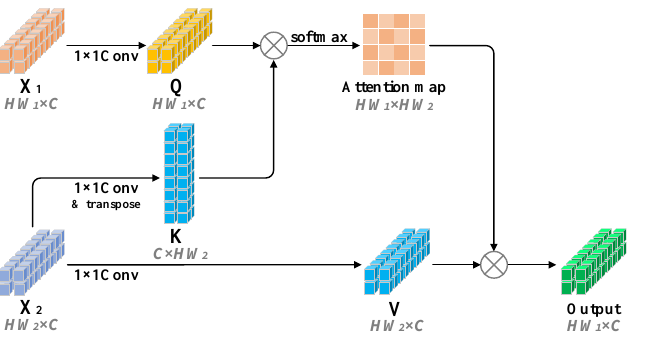
Figure 3. Cross-attention module for multi-modal features. The RGB feature map X 1 serves as a query token to interact with the patch tokens from multi-spectral features X 2 . (cid:78) denotes matrix